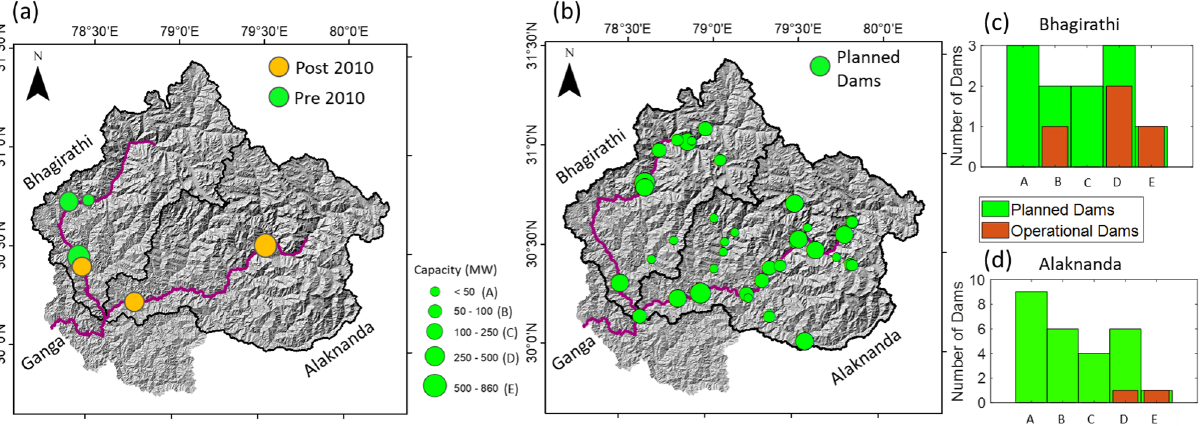
Figure 2. (a) Hydraulic structures in the UGB. The green and orange filled circles are showing the hydraulic structures commissioned pre-and post-2010 on the map. All these hydraulic structures’ circle sizes vary according to their hydropower generation capacity (MW). Further, A, B, C and D classes are defined based on each reservoir’s hydropower generation capacity. (b) The map shows planned hydraulic structures for the near future in the UGB. The QGIS Version 3.2 (https:// qgis. org/ en/ site/ forus ers/ downl oad. html) was used to generate these figures. Furthermore, the bar plots show the current hydraulic structures and planned hydraulic